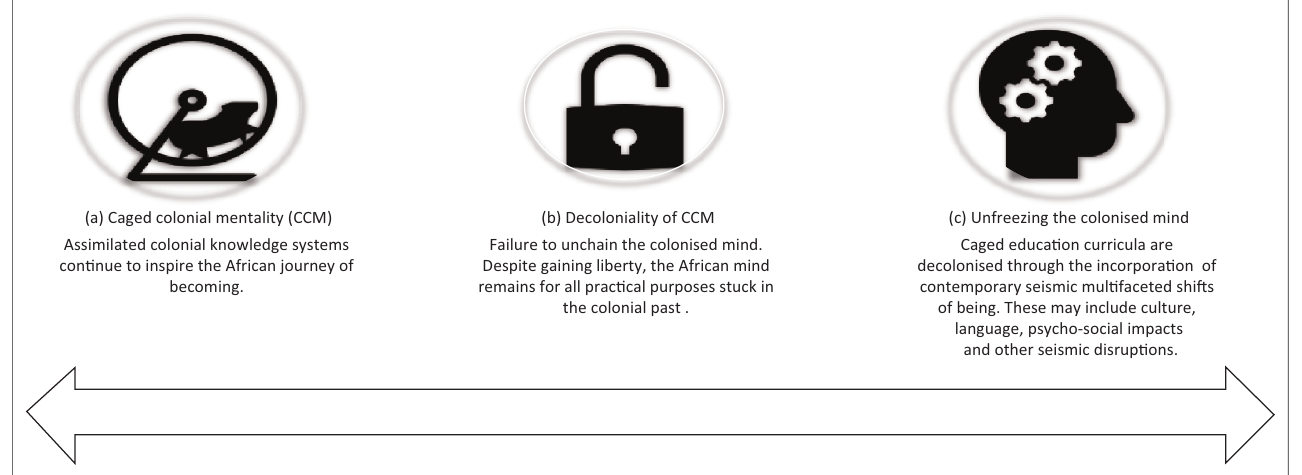
FIGURE 1: Multifaceted seismic matrix of shifts in African mind-set capturing and caging .